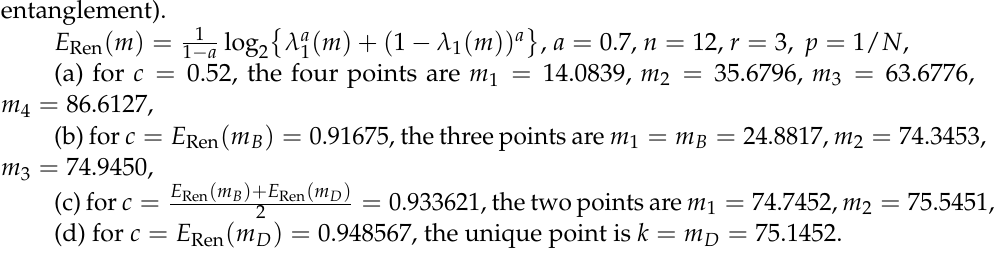
Numerical Example : (c.f. Figure 4, red dots stand for the approximate points of equal